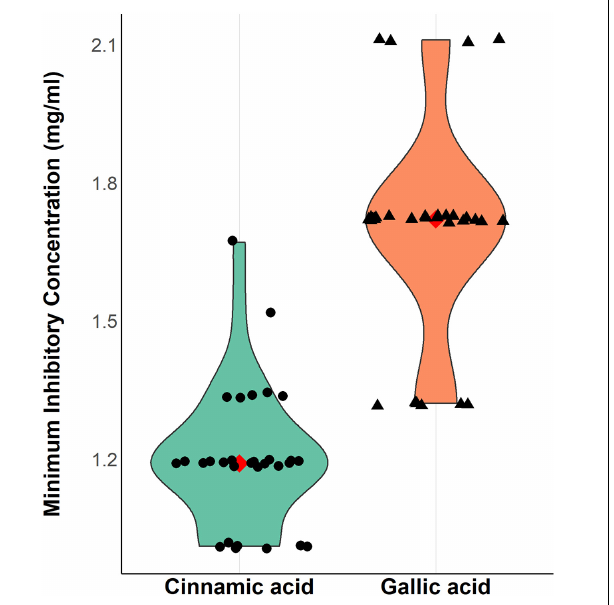
FIGURE 4 | Violin plots showing minimum inhibitory concentrations (mg/ml) of cinnamic and gallic acids against 30 MDR A. baumannii isolates. A strip chart displaying individual isolates was overlaid to illustrate the real dispersal of MIC values. The filled red diamond signifies the MIC mean value (1.2, 1.67 mg/ml for cinnamic and gallic acids, respectively) allowing better assessment of the data. Plot was created by R (“ggplot2”)